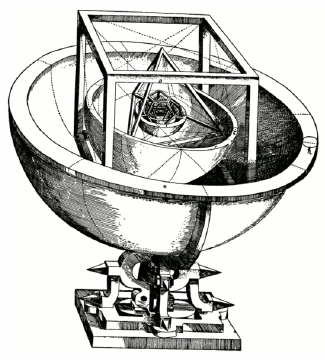
Figure 22: How to pronounce Saturnin using the International Phonetic Alphabet. There are multiple motivations for this